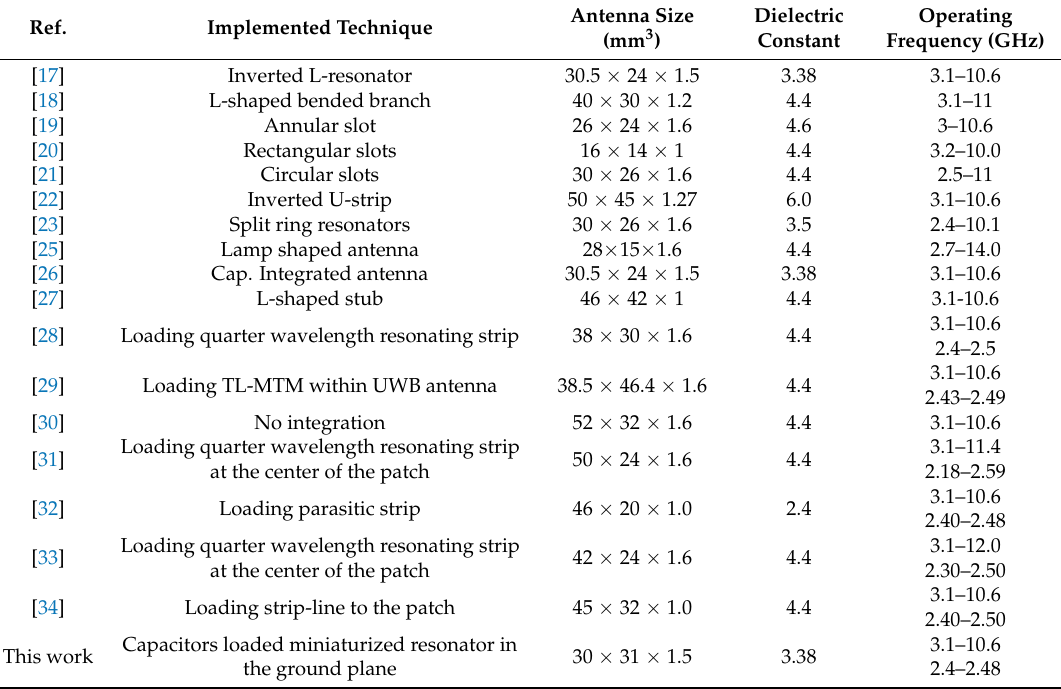
Table 2. Performance comparison with other designs in the literature.